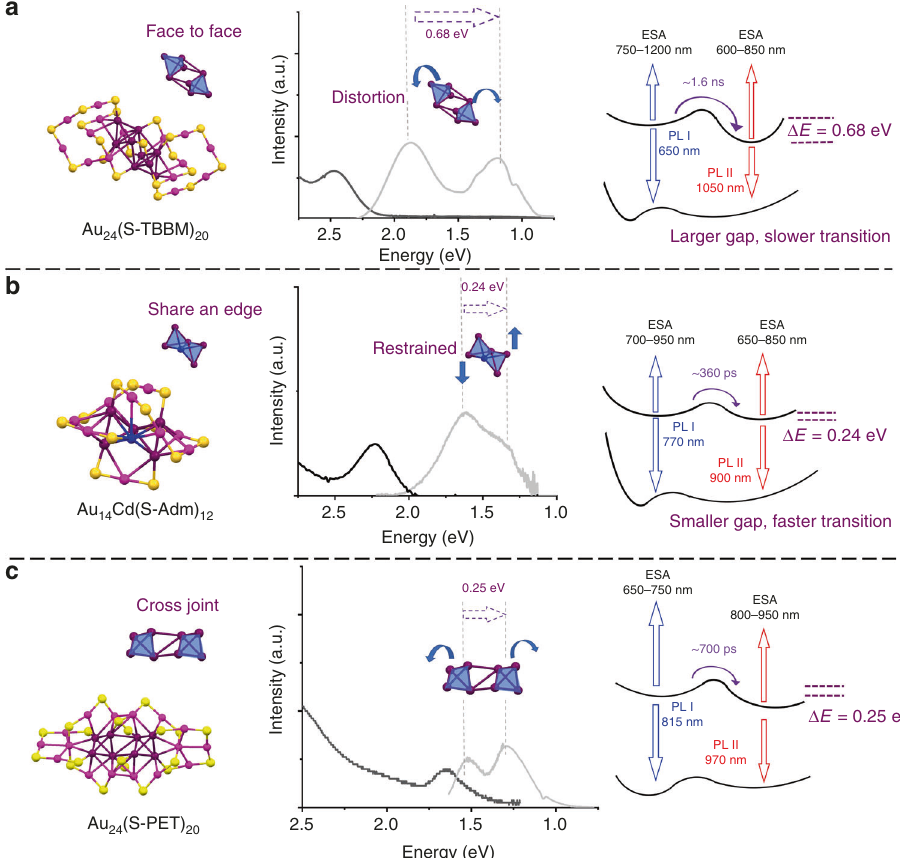
Fig. 7 Comparison of the three bi-tetrahedral series of Au nanoclusters. Atomic structure, optical properties, and relaxation diagram of a Au 24 , b Au 14 Cd, and c Au 24 ’ . In each panel, the atomic structure of the nanocluster is shown on the left, purple = core Au; magenta = surface Au; blue = Cd; yellow = S; the absorption (black) and PL (gray) spectra in the middle; and relaxation diagram on the right. Arrows denote the transitions between different electronic states. ESA excited state